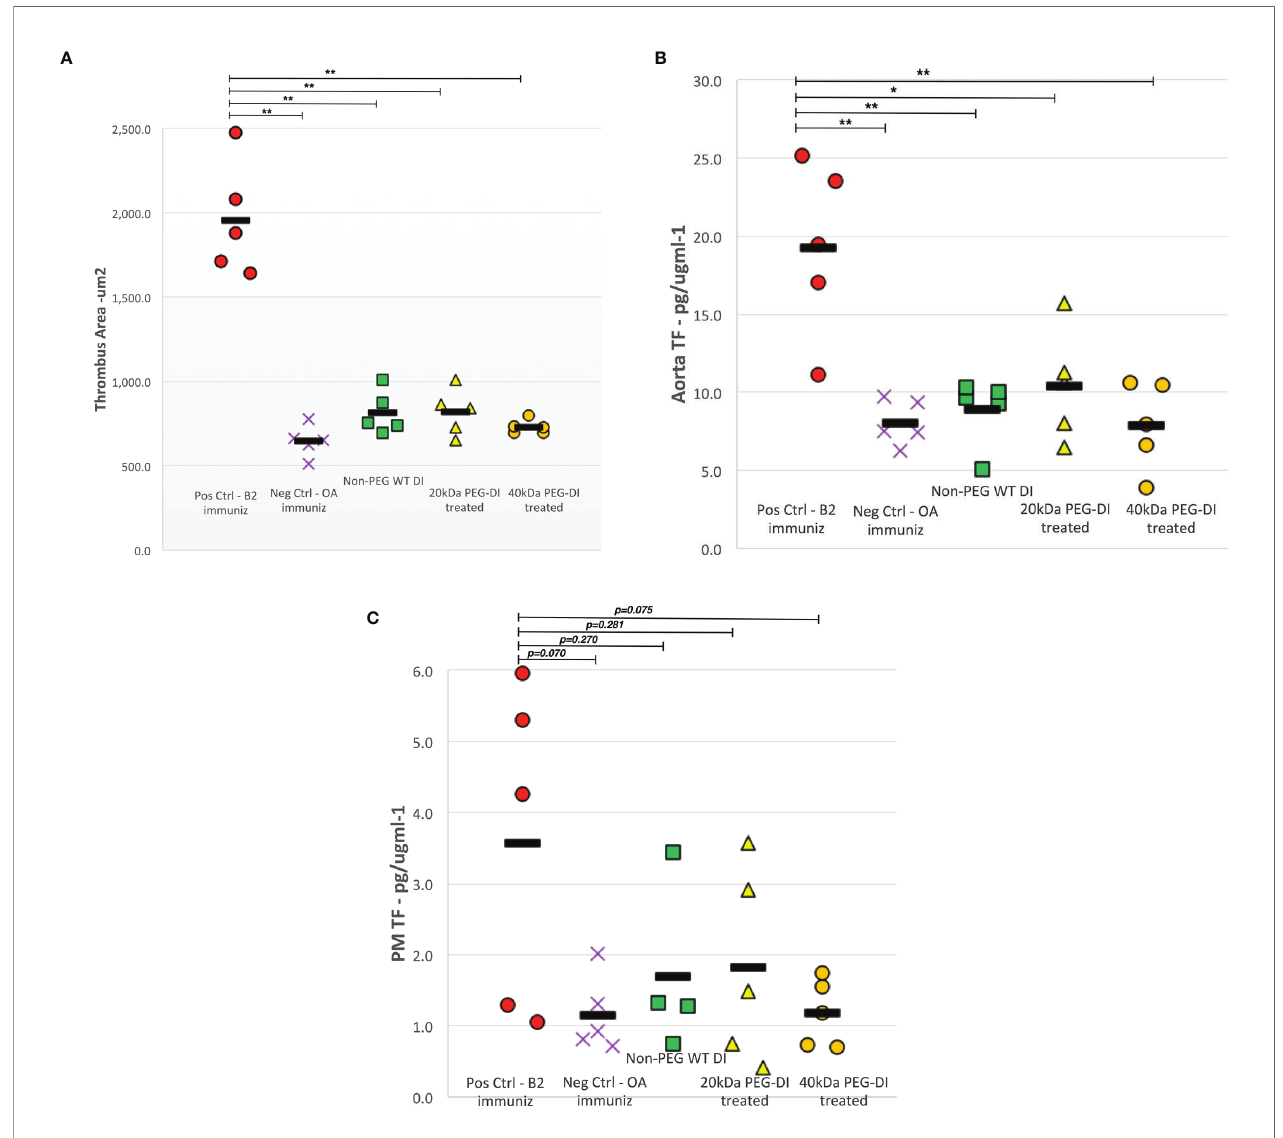
FIGURE 2 | Thrombus area, aortic and peritoneal macrophage tissue factor levels in chronic APS mouse model. Both thrombus area (A) and aortic TF (B) levels decreased signi fi cantly in b 2 GPI-immunized mice treated with non-PEG-DI, 20kDa PEG-DI and 40kDa PEG-DI compared to b 2 GPI-immunized positive control mice. The abrogated levels of thrombus development and aortic TF were similar to that seen in negative control mice. While there was a trend of decreased peritoneal macrophage TF (C) levels in all domain I treated mice, the noted reductions were not statistically signi fi cant. (*p<0.01,